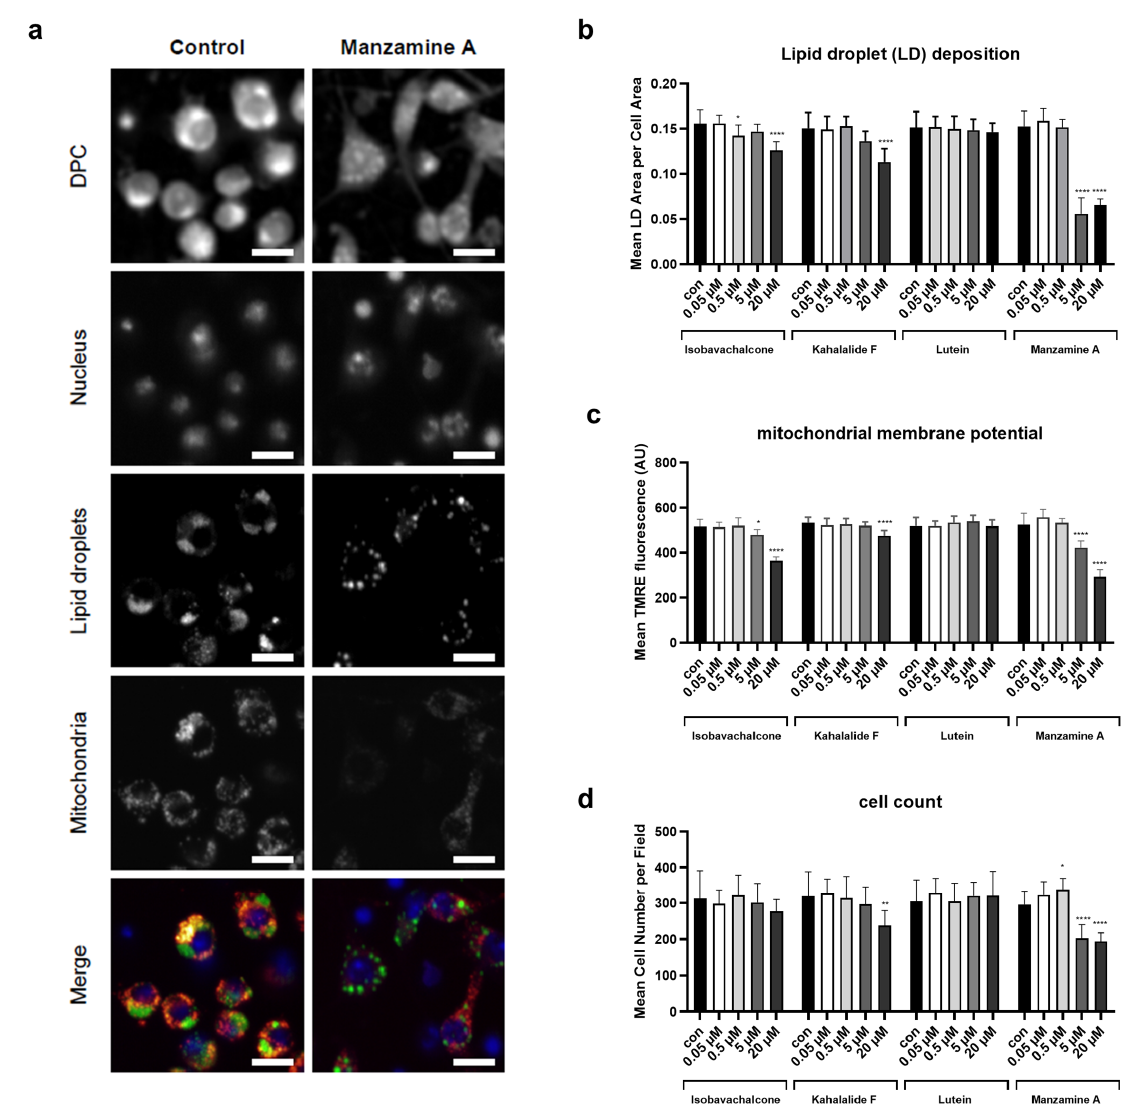
Figure 4. High content microscopy assay with Drosophila melanogaster S2R+ cells. S2R+ cells were incubated for 18 h with the different concentrations of the compounds Isobavachalcone, Kahalalide F, Lutein and Manzamine A. The control group was treated with DMSO (0.2%). ( a ) Representative picture of the high content staining in control and Manzamine A (20 µM) treated cells where merge is from nucleus (blue, Hoechst 33342), lipid droplets (green, BODIPY FL C12) and mitochondria (red, TMRE). Digital phase contrast is calculated from transmitted light images and shows the unstained cell morphology. Scale bar = 10 µm. ( b ) Quantification of mean LD area per cell. ( c ) Quantification of mean mitochondrial membrane potential per cell. ( d ) Quantification of cell number per field. Individual cells were analyzed from four fields per well of biological triplicates. One-way ANOVA for each compound, confidence interval 95%. In all panels, asterisks (*) denote statistical significance: * p value ≤ 0.05, ** p value ≤ 0.01, **** p value ≤ 0.0001 compared with control.